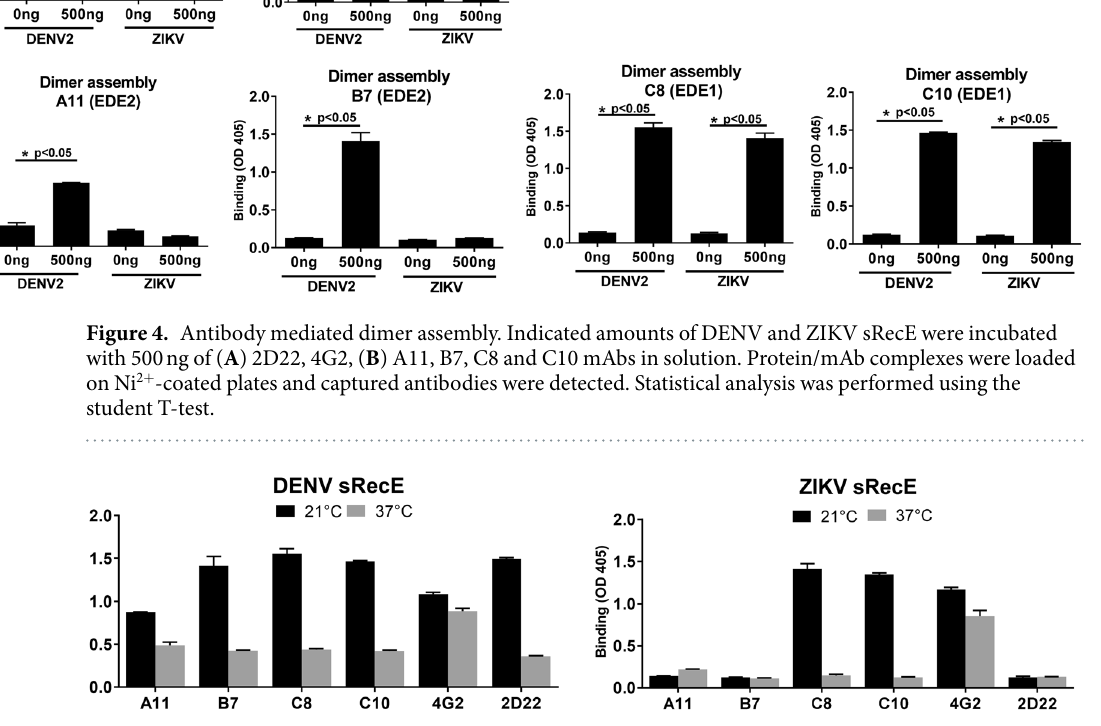
Figure 5. Antibody mediated dimer assembly is a temperature dependent process. The effect of temperature on mAb mediated dimer assembly was analyzed by incubating 500 ng mAb with 500 ng DENV2 or ZIKV sRecE. sRecE-mAb incubations were performed at 21 °C or 37 °C and loaded on Ni 2 + -coated plates and captured antibodies were